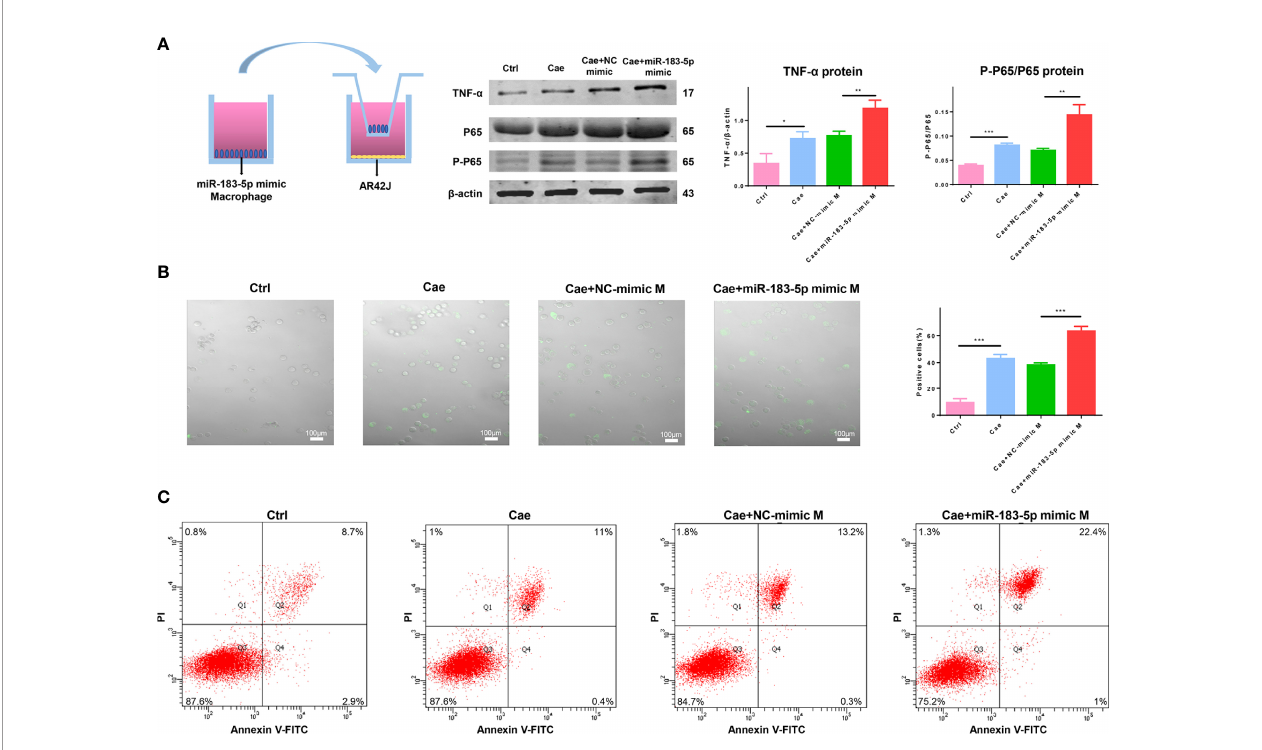
FIGURE 7 | Macrophages overexpressing miR-183-5p aggravate AC damage. (A) Representative western blot and quanti fi cation of P-P65/P65 and TNF- a levels in ACs from the four groups: Ctrl, Cae, Cae+NC-mimic M, and Cae+miR-183-5p mimic M. (B) Trypsinogen activation assay in ACs from the above groups. The percentage of positive cells (white arrow) was calculated to quantify the degree of trypsinogen activation. (C) Representative fl ow cytometry results for necrosis in ACs from the above groups. All experiments were repeated three times. * p <0.05, ** p <0.01, *** p <0.001. Ctrl: PBS-treated acinar cells, Cae: caerulein-treated acinar cells, Cae+NC-mimic: M caerulein-treated acinar cells cocultured with macrophages transfected with the NC-mimic, Cae+miR-183-5p mimic M: caerulein- treated acinar cells cocultured with macrophages transfected with the miR-183-5p